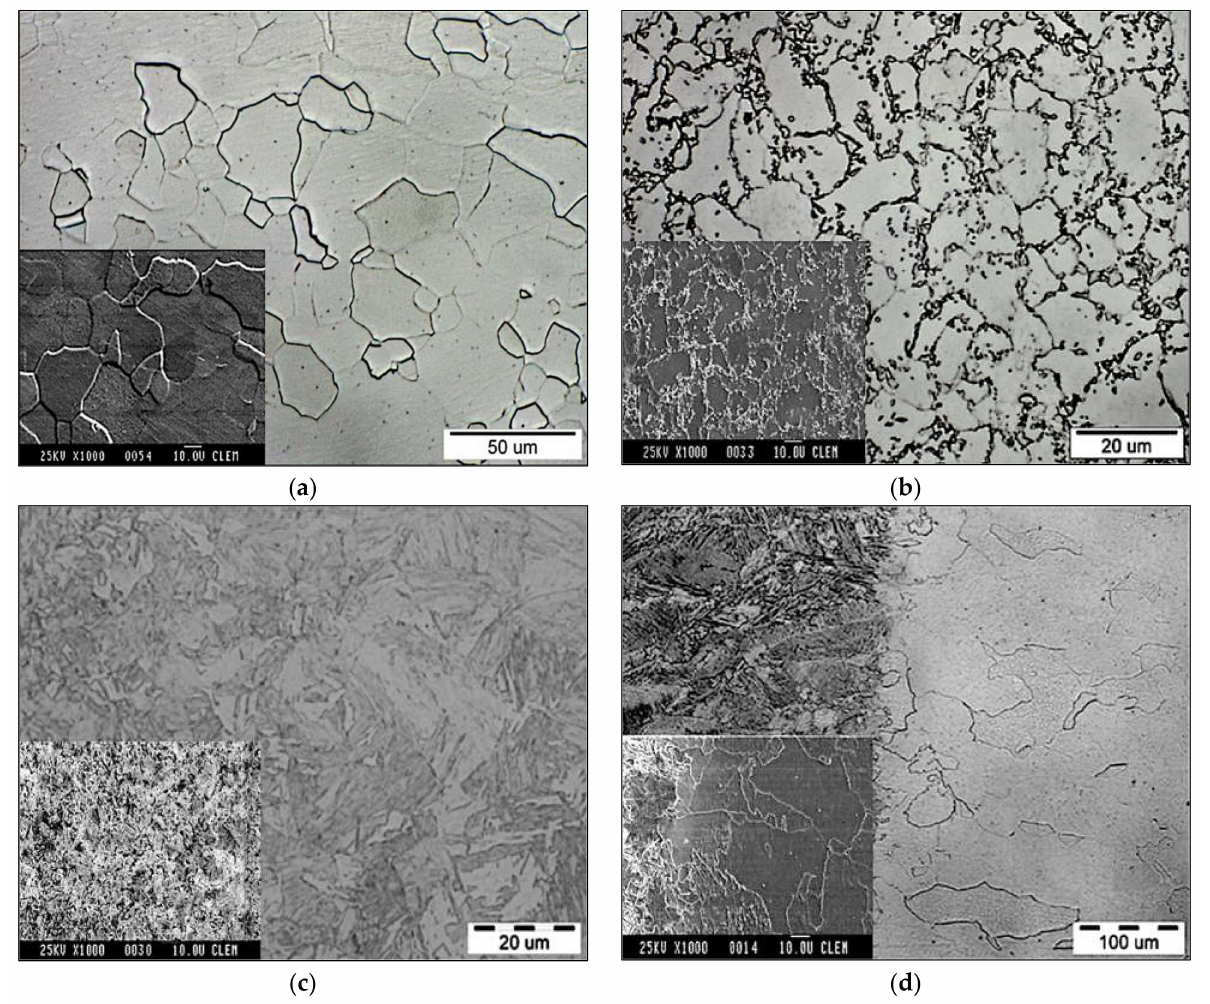
Figure 6. The microstructure of investigated steels: ( a ) CR180IF steel; ( b ) DP600 steel; ( c ) fusion zone; ( d ) heat-affected zone of CR180IF.